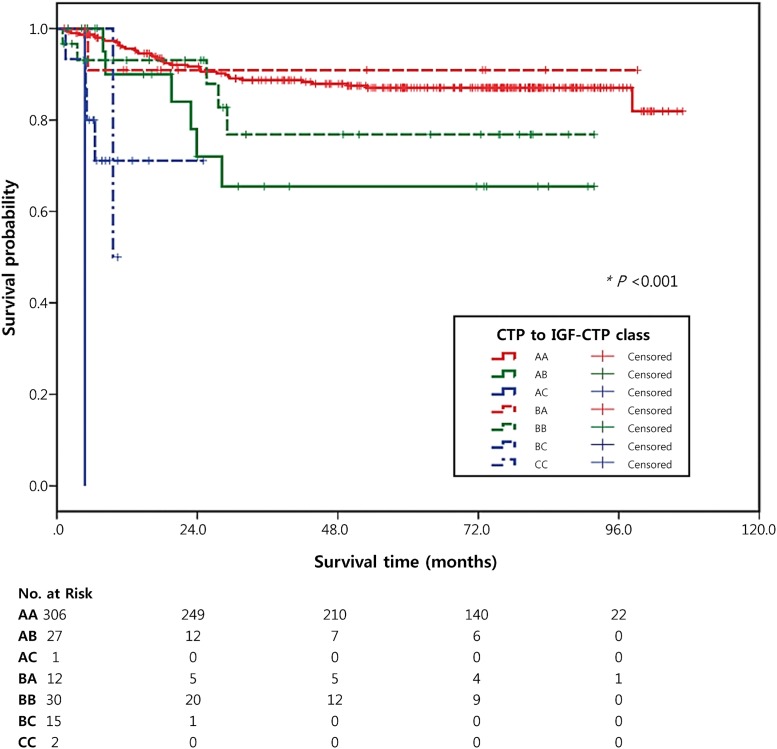
Kaplan-Meier survival curves of patients according to CTP class and IGF-CTP class.Tables below each graph show the numbers of patients at risk at various time points.